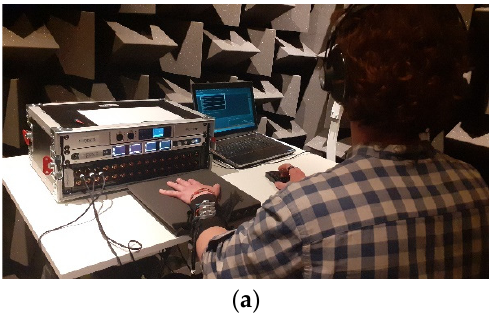
Figure 4. A participant wearing a vibrotactile sleeve with his hand on the cushion, using the head- phone to block out external auditory cues and responding to the vibrotactile feedback by pressing the correct key on the wireless keyboard. There were two experiments: ( a ) on the upper side of the forearm in experiment one; ( b ) and on the underside of the forearm in experiment two.